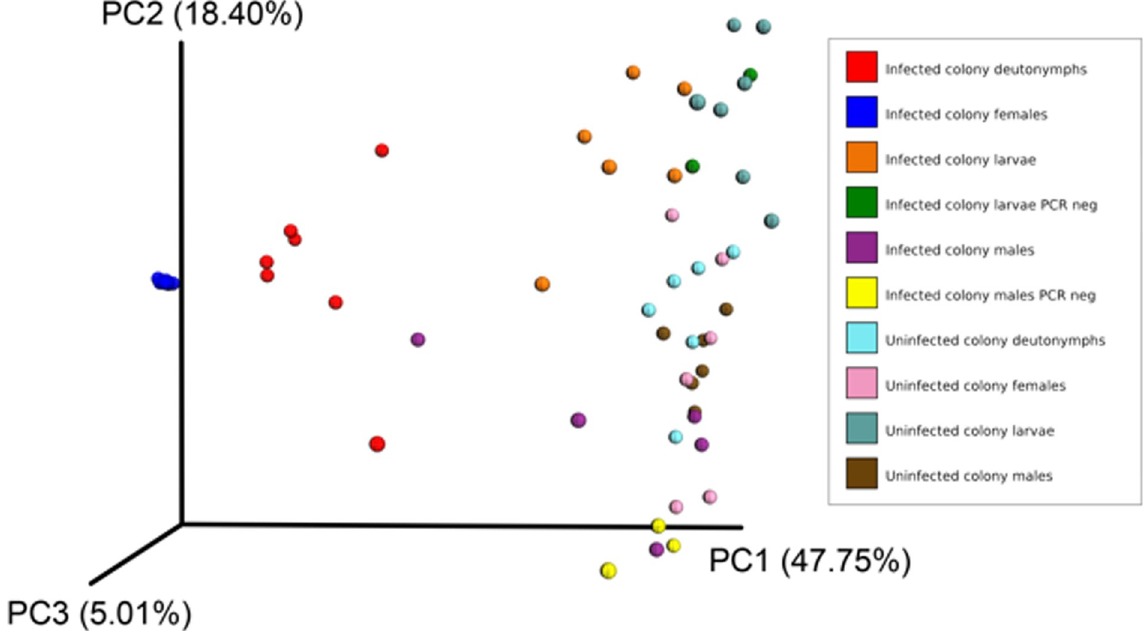
Fig 3. Weighted Principal Coordinates Analysis (PCoA) of the bacterial species observed in different stages of L . imphalum mites.